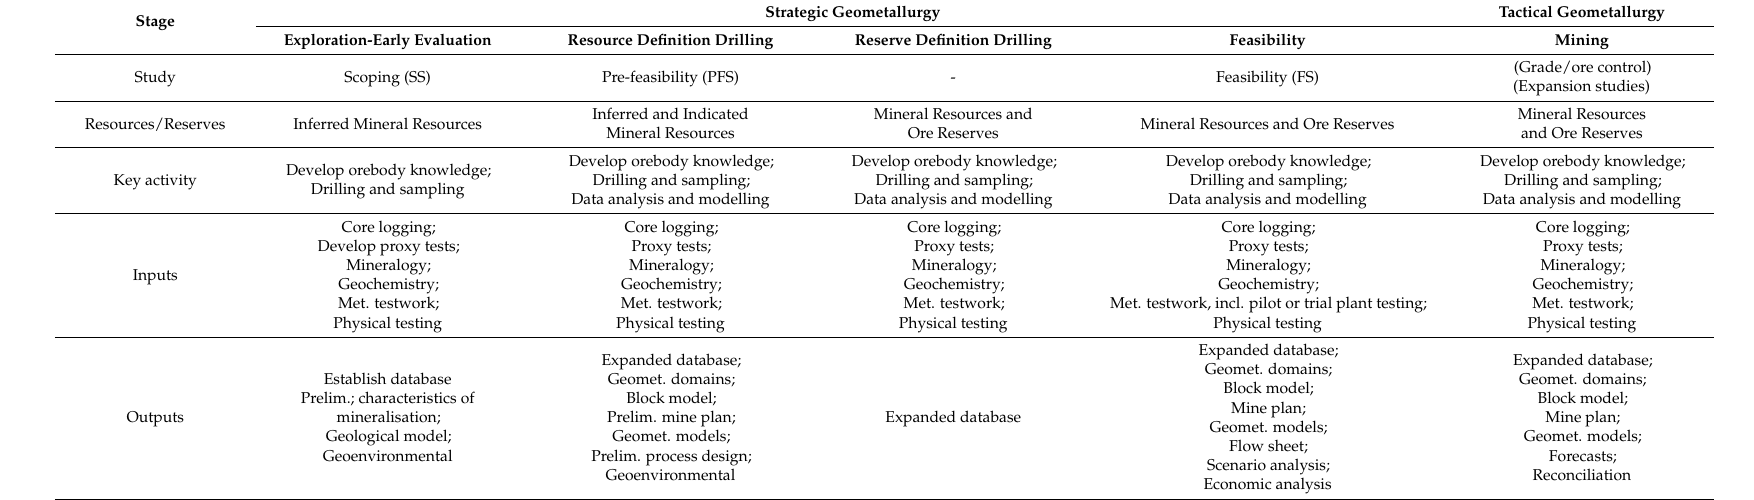
Table 5. General MVC showing broad metallurgical-geometallurgical activities, inputs and outputs (after